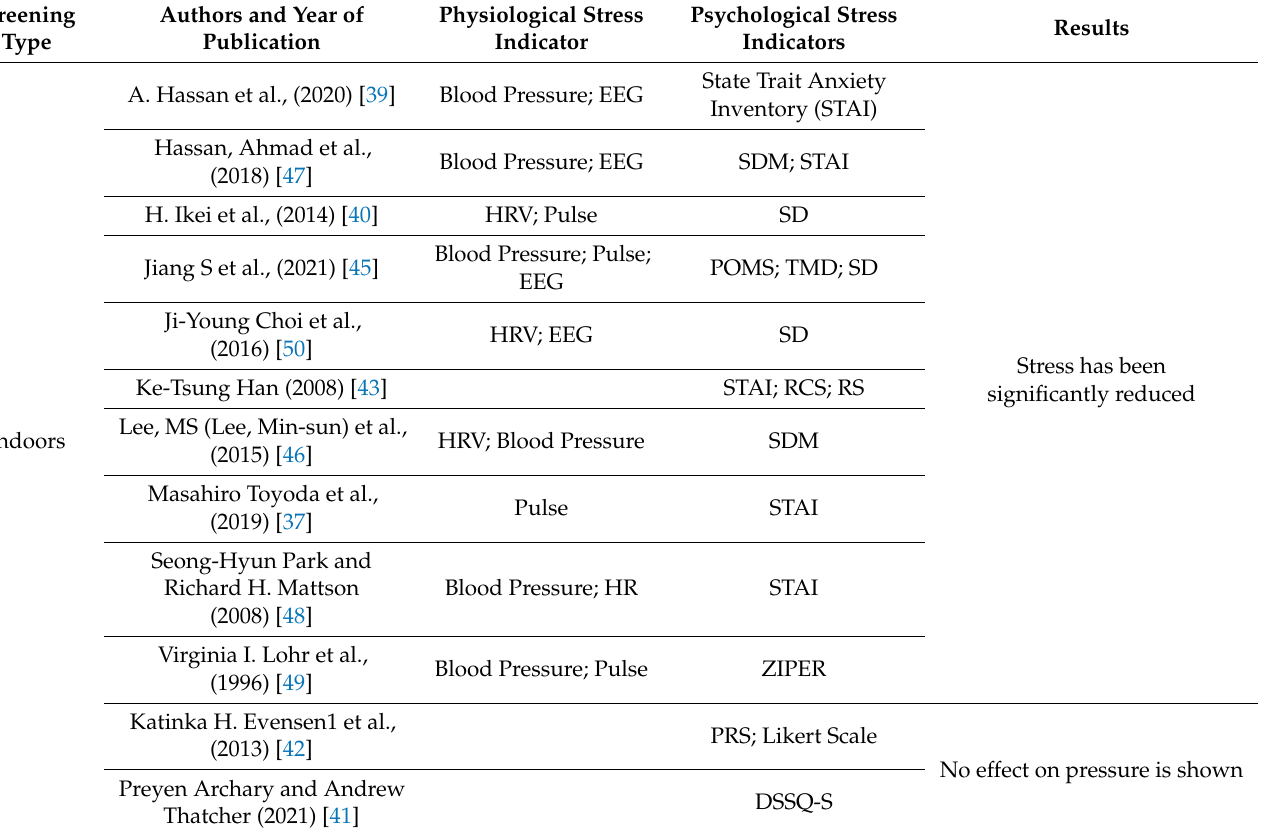
Table 3. Interventions and effectiveness